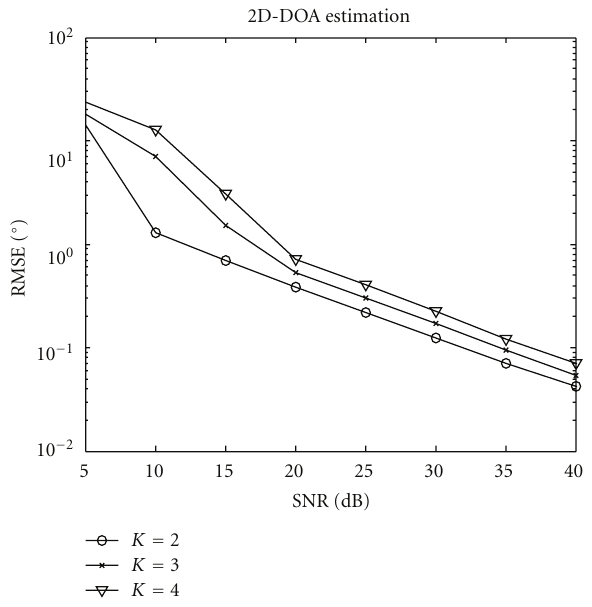
Figure 9: Frequency estimation with di ff erent sources.